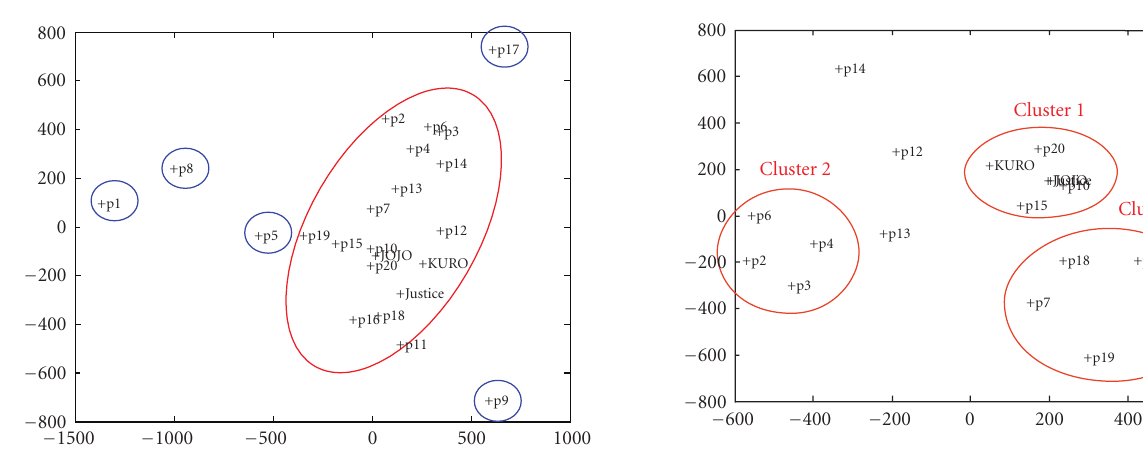
Figure 13: MDS result for data after exclusion of the outliers.